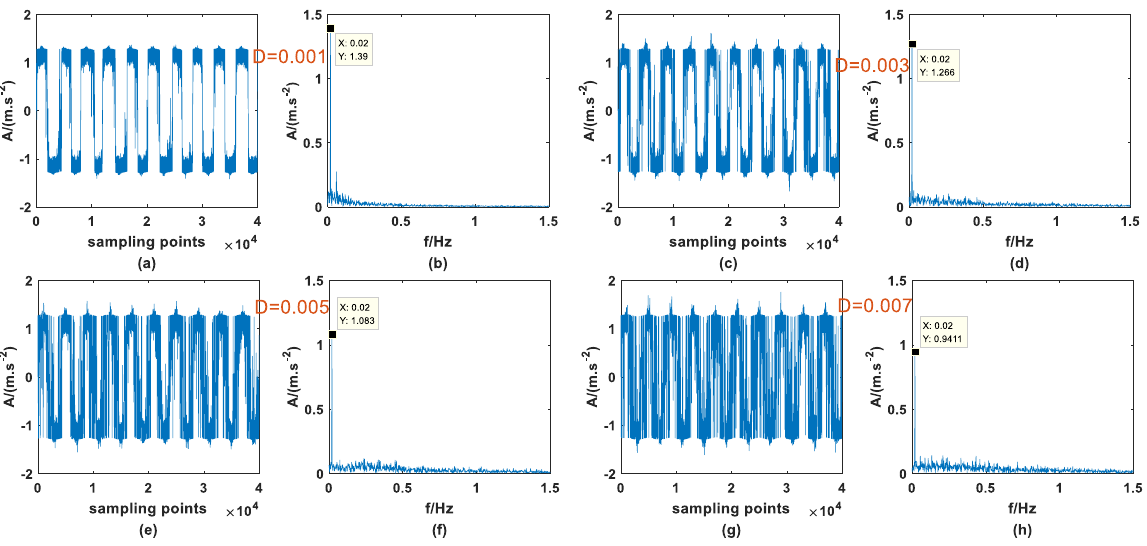
Figure 13. Output signal with dichotomous noise of different D ( a ) time domain ( D = 0.001), ( b ) frequency domain ( D = 0.001), ( c ) time domain ( D = 0.003), ( d ) frequency domain ( D = 0.003), ( e ) time domain ( D = 0.005), ( f ) frequency domain ( D = 0.005), ( g ) time domain ( D = 0.007), ( h ) frequency domain ( D = 0.007).